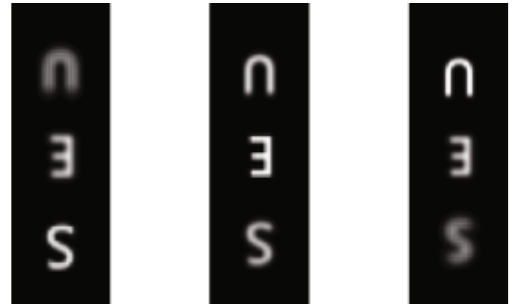
Figure 3: The original distribution of a point light source array on three di ff erent